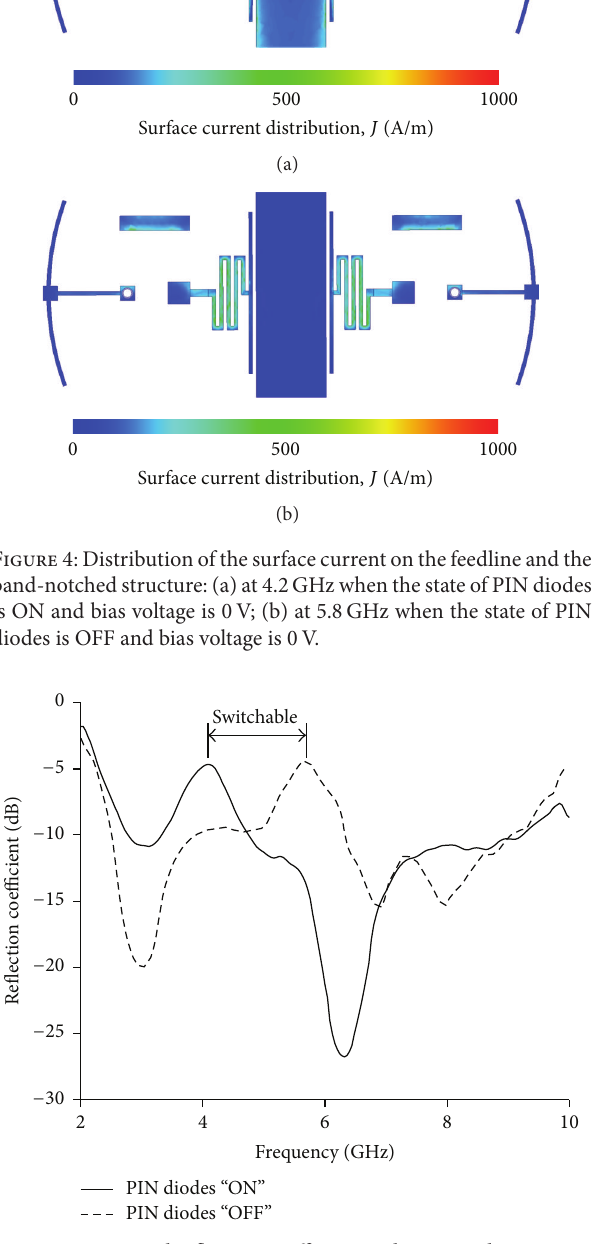
Figure 5: Measured reflection coefficient under ON and OFF states of PIN diode when the reverse voltage on varactors is fixed at 0 V. diodes are ON, the electric length of resonance is relatively longer, which would lead to a lower resonant frequency.